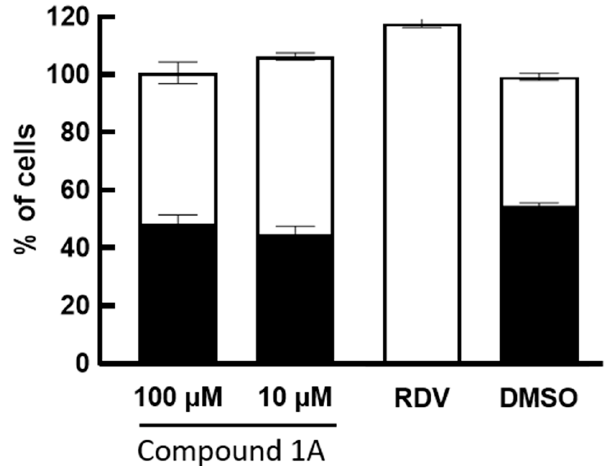
Figure 5. Antiviral activity assay. Percent (%) total cells normalized to the DMSO-treated control are shown as white bars. % infected cells are shown as black bars. Means and standard deviations of triplicate wells are shown. No antiviral effect was detected at any doses tested for compound 1A. Remdesivir (RDV 2 mM) was used as positive control and resulted in almost complete inhibition of infection.